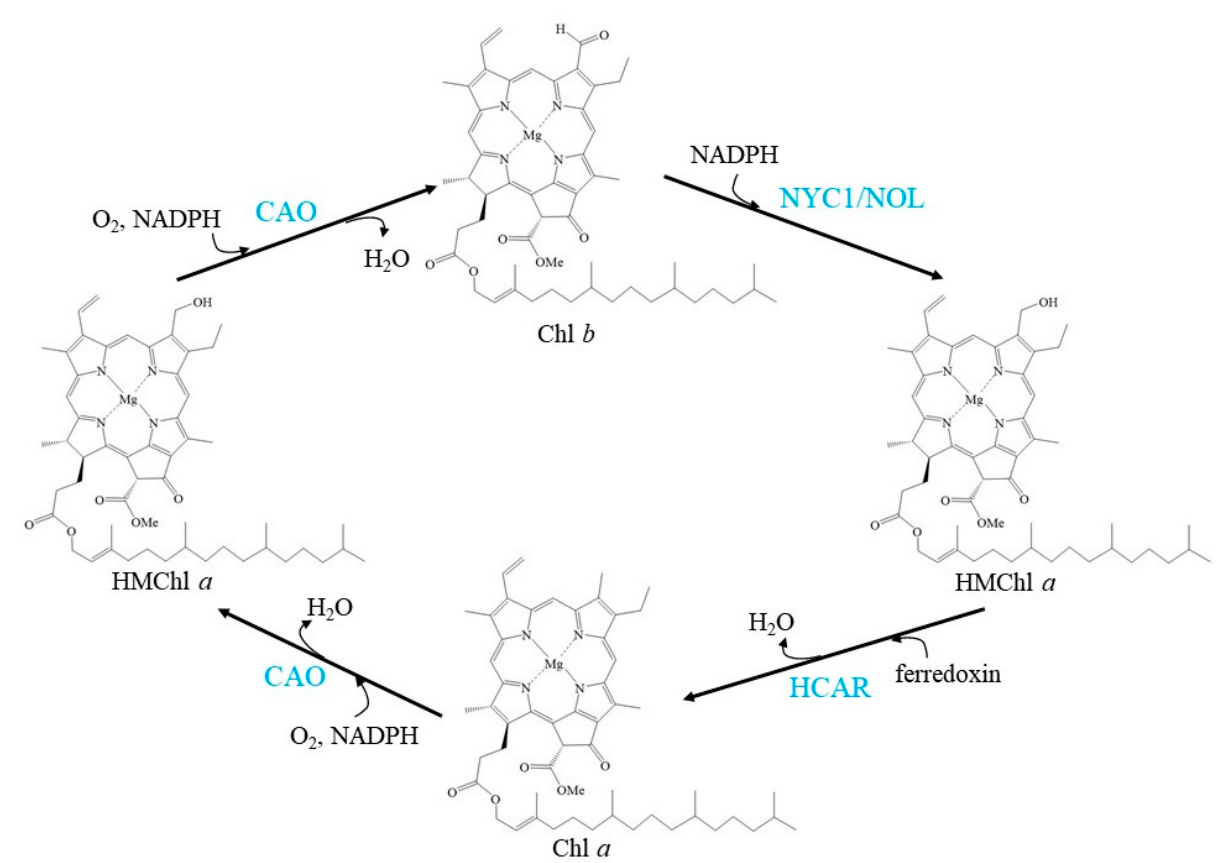
Figure 1. Schemes of the enzymatic reactions in Chl cycle. Blue characters indicate the enzymes.